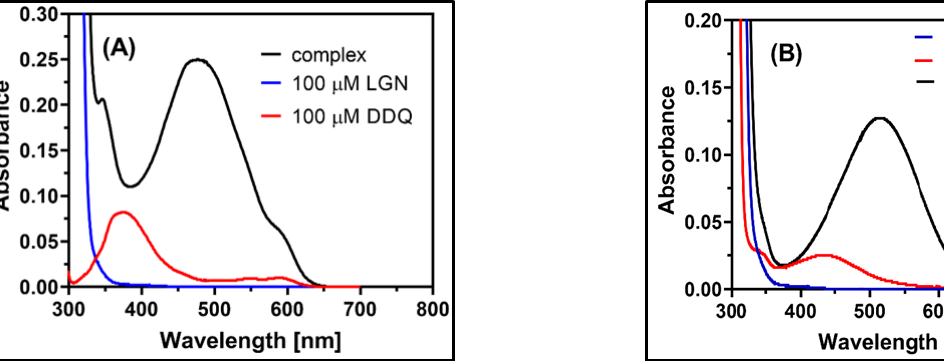
Figure 4. Electronic absorption spectra of ( A ) blue line for LGN (1 × 10 – 4 M), red line for DDQ 1 × 10 – 4 M and complex with black line of LGN-DDQ (1:1); ( B ) blue line for LGN (1 × 10 – 4 M), red line for CHA 1 × 10 – 4 M and complex with black line of LGN-CHA (1:1) complex (1 × 10 – 4 M + 1 × 10 – 4 M) in line for CHA 1 × 10 –4 M and complex with black line of LGN-CHA (1:1) complex (1 × 10 –4 M + MeCN at room temperature. 1 × 10 –4 M) in MeCN at room